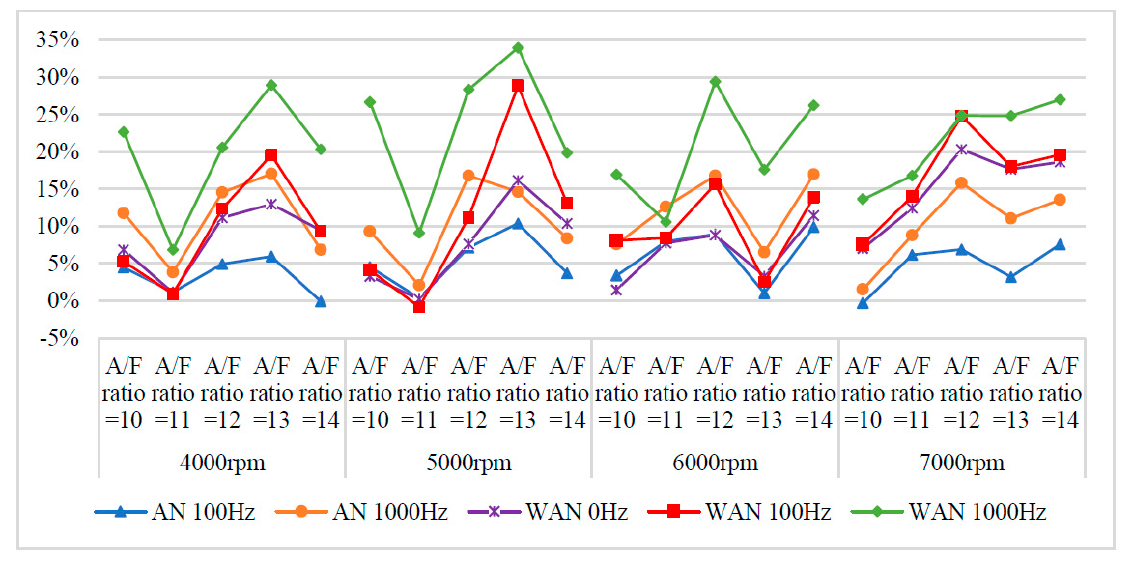
Figure 10. The HC change rate of WAN and AN with different frequencies.